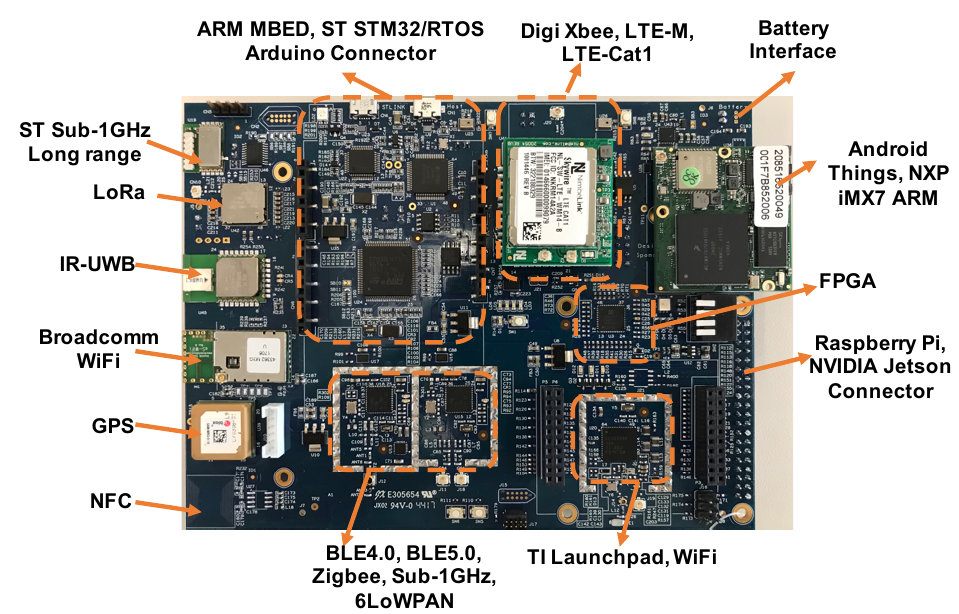
Figure 4. Our own designed computing